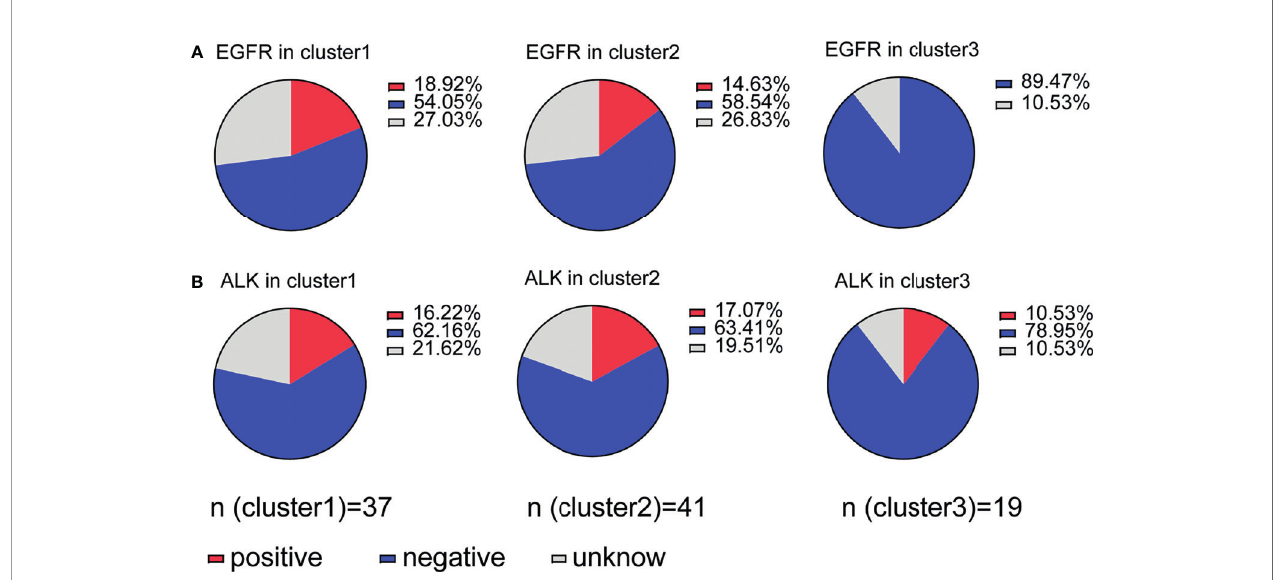
FIGURE 6 | Association of immune suppression statuswith EGFRorALK mutation. (A) Distribution of patients with EGFR mutations in clusters1-3; clusters1 and 2 (immune suppression) showed a relationship with mutation status, but cluster 3 did not. (B) Patients with ALK mutations were evenly distributedbetween allthree